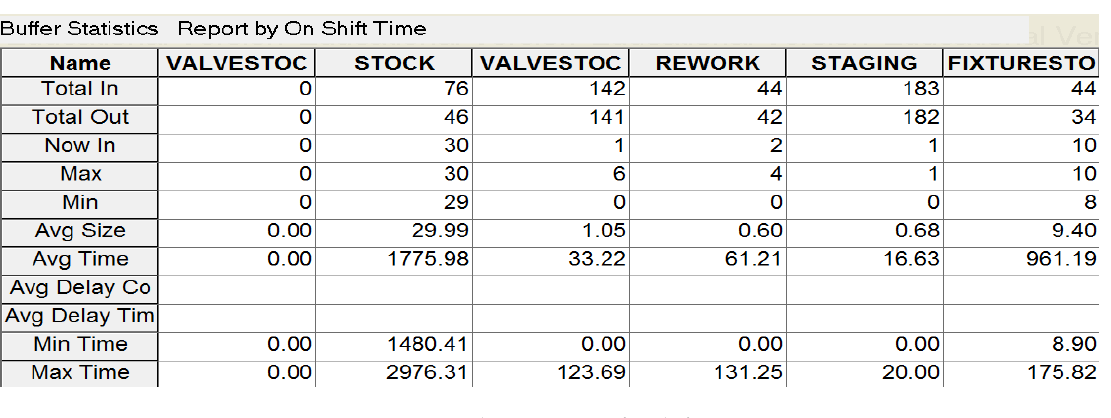
Figure 12. Machine statistics for shift time.